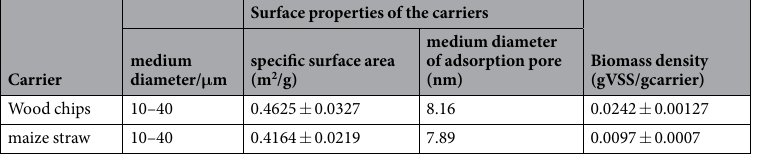
Table 1. Surface properties of the carriers and Biomass